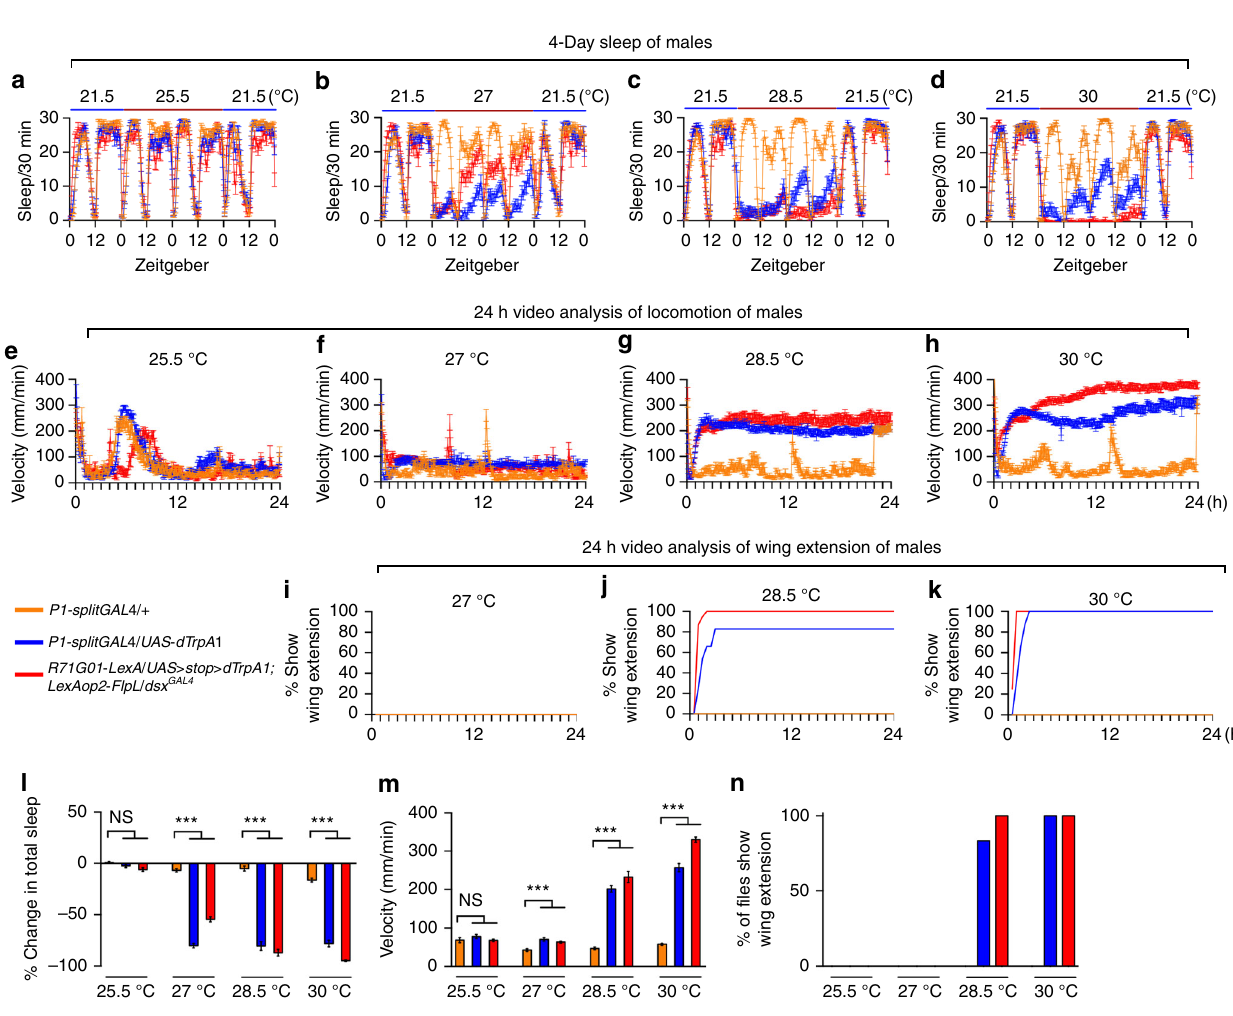
Fig. 3 Activity-dependent regulation of courtship and sleep by P1. a – d Sleep pro fi les of males with P1 neurons activated at indicated temperatures, as well as control males. n = 32 for each. e – h Velocity of males with P1 neurons activated at indicated temperatures over 24 h of video tracking. n = 24 for each. i – k Percentage of males with P1 neurons activated at indicated temperatures shows wing extension over 24 h of video tracking. n = 48 for each. l Percentage of sleep changes from 21.5 °C to indicated temperatures. m The mean velocity of males with P1 neurons activated at indicated temperatures over 24 h. n Percentage of males with P1 neurons activated at indicated temperatures show wing extension. *** p < 0.001, unpaired t- test. NS , not signi fi cant. Error bars indicate